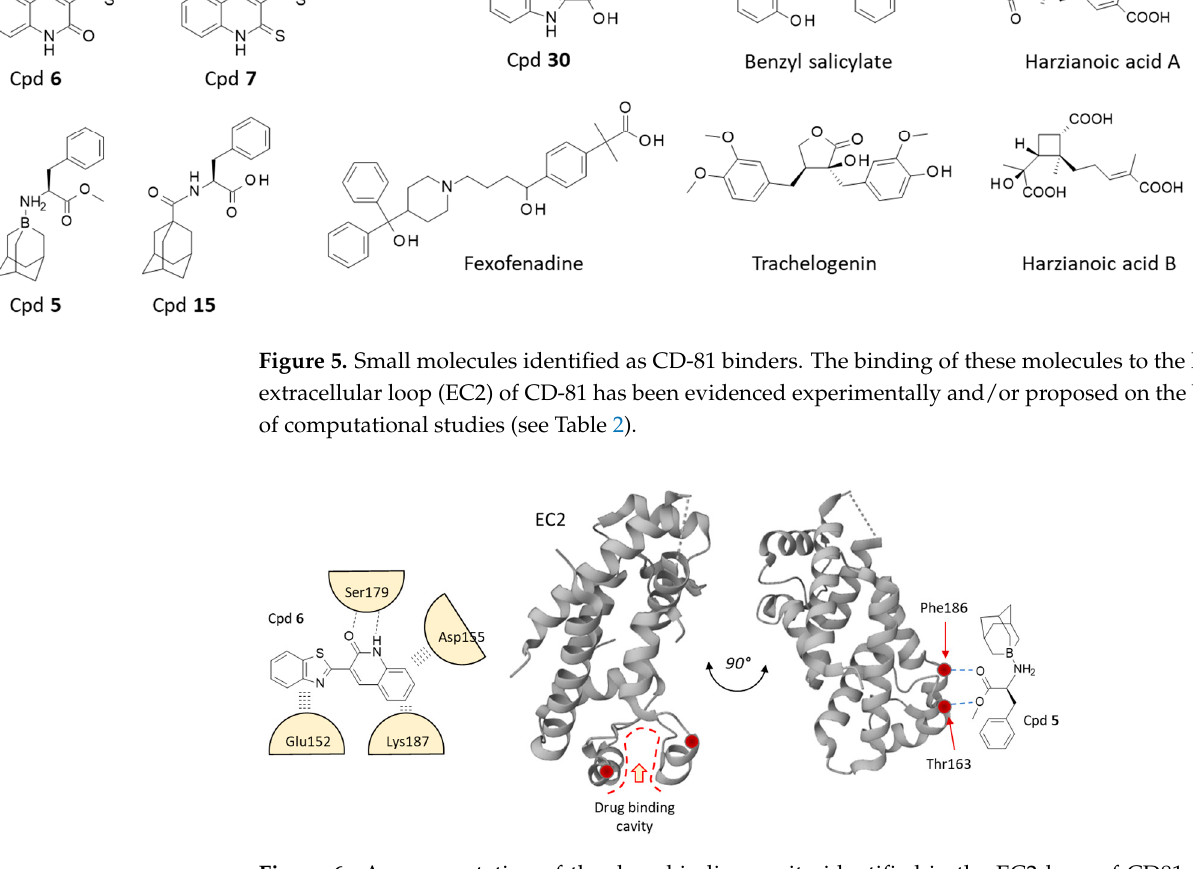
Figure 6. A representation of the drug binding cavity identified in the EC2 loop of CD81. The boraadamantane compound 5 and benzothiazole derivative 6 have been predicted to bind to CD81- EC2 on the basis of molecular docking and molecular dynamics simulation [146,148]. Specific interaction between the compound and the indicated amino-acid has been underlined. All compounds indicated in Figure 5 would fit into the binding cavity delineated by the indicated key residues.